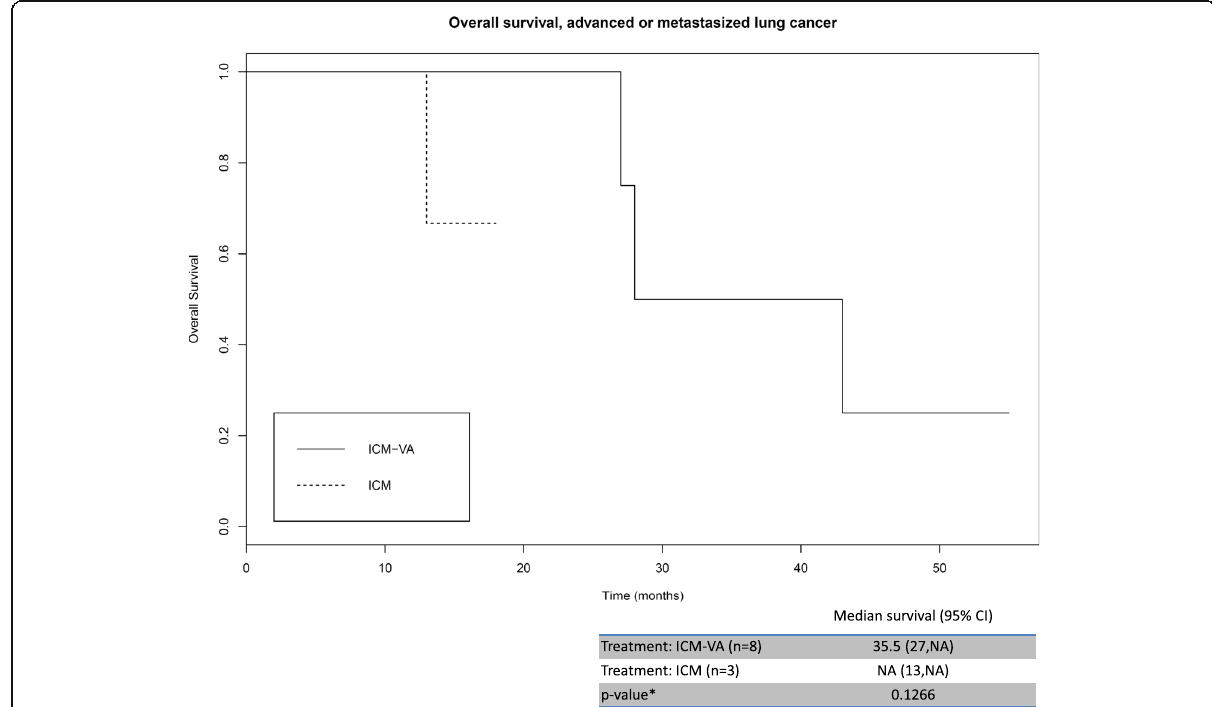
Fig. 2 Kaplan-Meier curves by treatment arm; advanced or metastasized lung cancer. Kaplan – Meier curves for survival by treatment arm during total observation period (55 months, 4.6 years) and median survival in months for patients with advanced or metastasized lung cancer. ICM, immune checkpoint inhibitor nivolumab, ICM-VA, therapy with immune checkpoint inhibitors and concomitant Viscum album L.; CI, confidence interval. *based on log rank